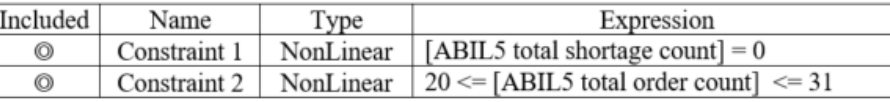
Figure 12. Setting values of constraints for drug ABIL5 in Scenario 2.